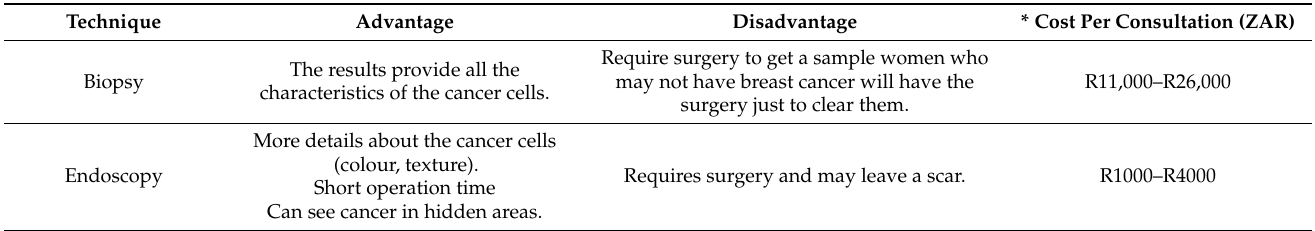
Table 2. Advantages and disadvantages of different techniques for the diagnosis of breast